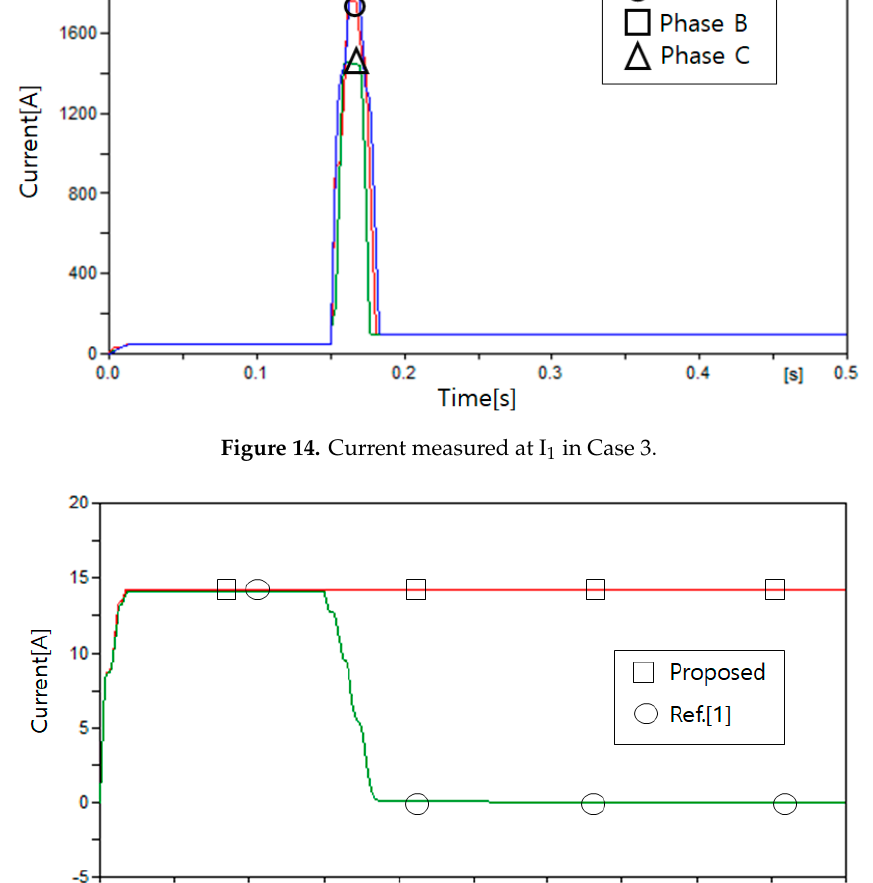
Figure 15. Current measured at Load 3 in Case 3.